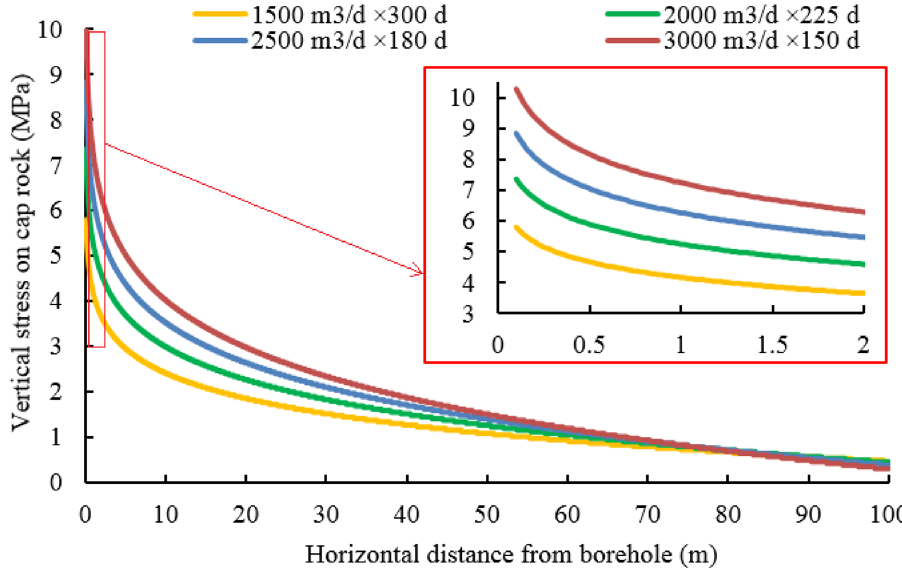
Fig. 5 Vertical stress at the interface between coal and caprock interface under various CO 2 injection rates with same injection